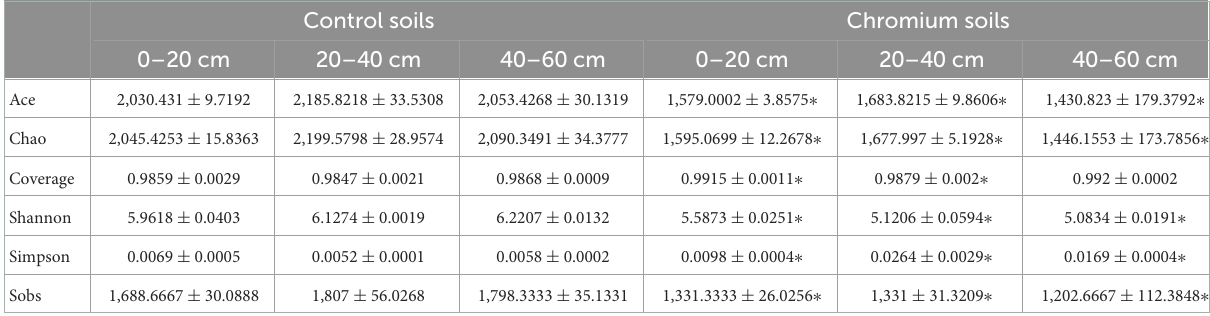
TABLE 3 Alpha diversity analysis for microbial diversity.